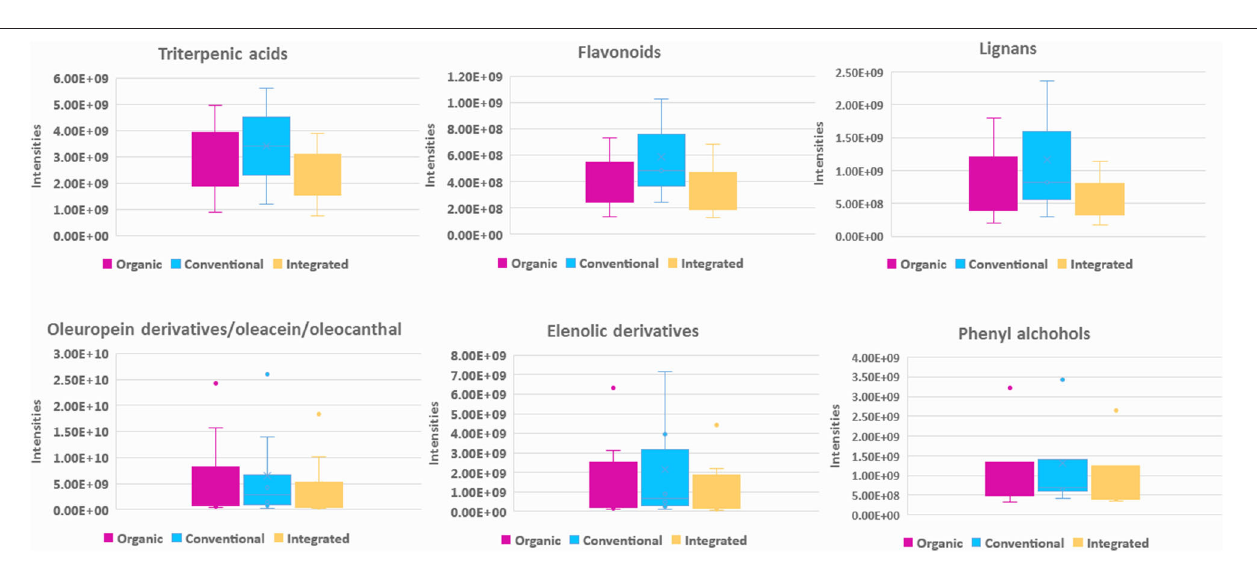
FIGURE 7 | Box-plots representing intensities of statistical significant compounds grouped according to their chemical class; triterpenic acids, flavonoids, lignans, secoiridoids (oleuropein derivatives, oleacein, and oleocanthal) (elenolic derivatives), and phenyl alcohols. Box-plots are presented according to cultivation practice: organic (magenta), conventional (blue), and integrated (light